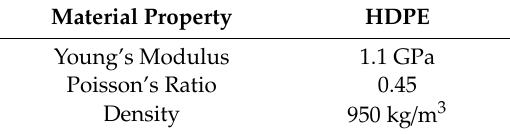
Figure 2. Group velocity dispersion curves of a 3 inch diameter, 10 mm thick HDPE pipe. Table 1. Assumed material properties in the numerical simulation. HDPE: high density